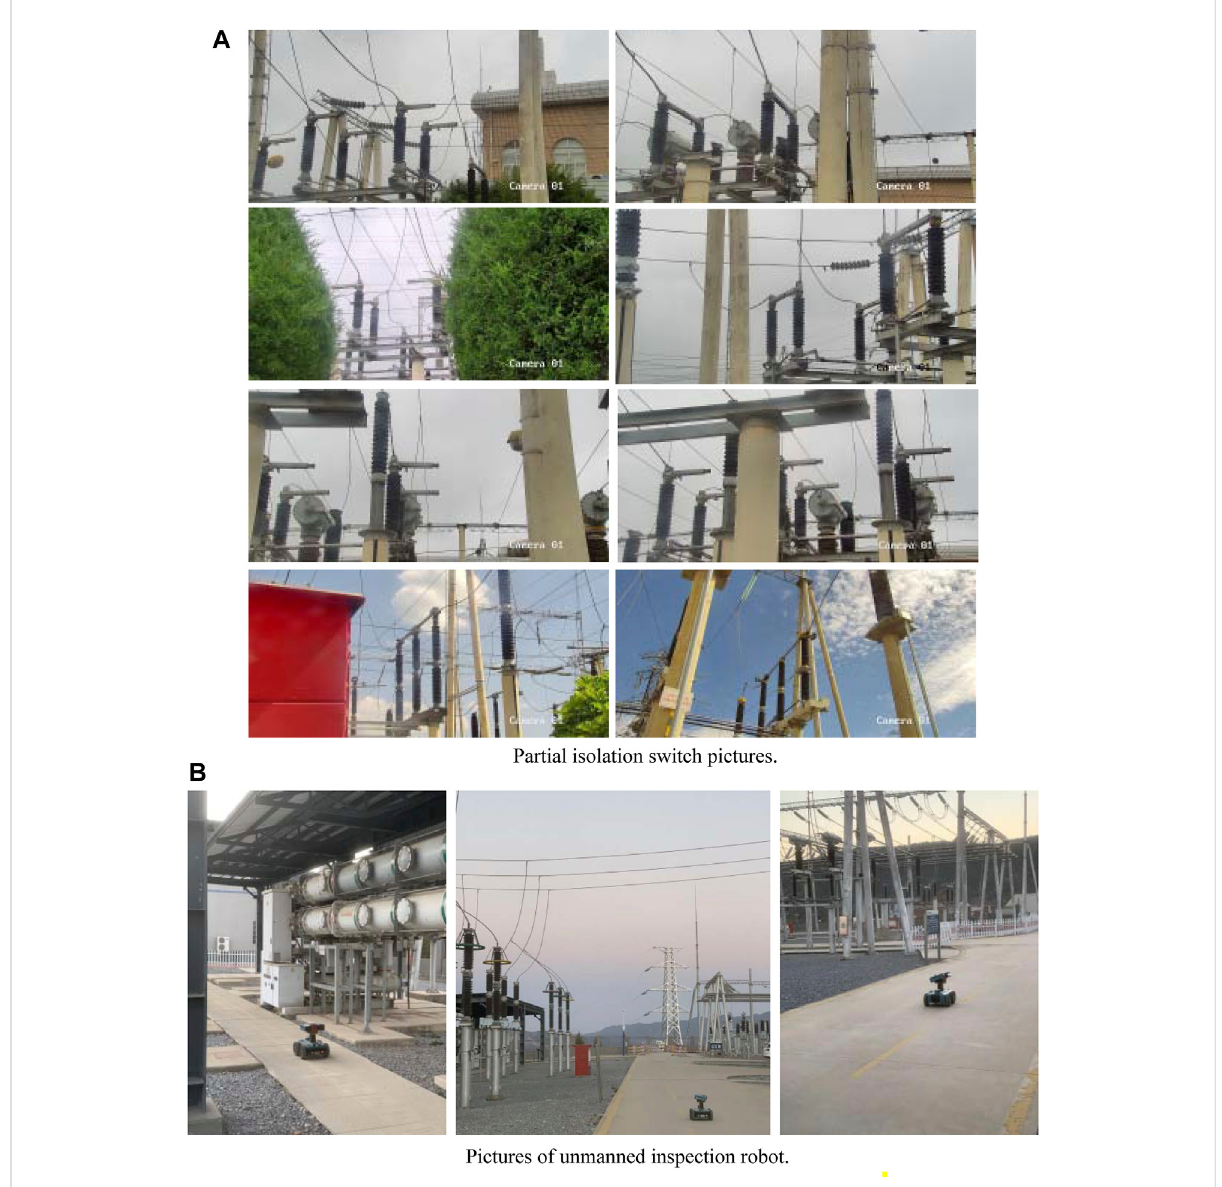
FIGURE 5 Pictures of unmanned inspection robot and isolation switch. (A) Partial isolation switch pictures. (B) Pictures of unmanned inspection